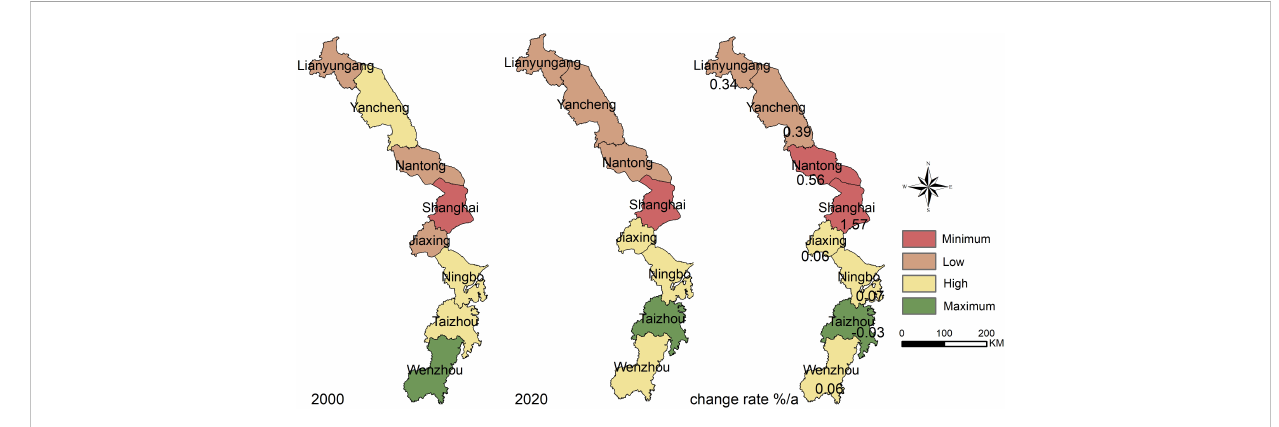
FIGURE 3 Spatial distribution of carrying capacity and change trend classi fi cation in the Yangtze River Delta coastal zone from 2000 to 2020.